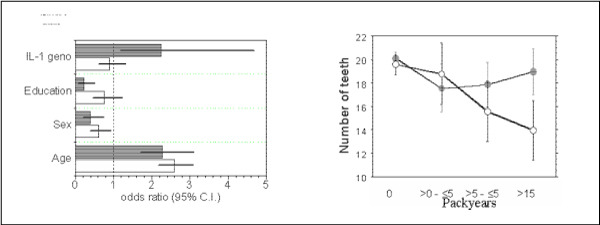
Impact of IL-1 genotype on risk of periodontitis. 5a (left): Results of logistic regression analysis for non-smokers (open bars) and smokers (shaded bars). Shown are the odds ratios including the 95% confidence intervals (C.I.). 5b (right): Mean number of teeth in subjects of different smoking exposure as given at the abscissa. Open symbols: IL-1 genotype positive subjects, closed: IL-1 genotype negative. ANOVA packyears p < 0.0001, genotype p = 0.015, interaction packyears*genotype p = 0.013.